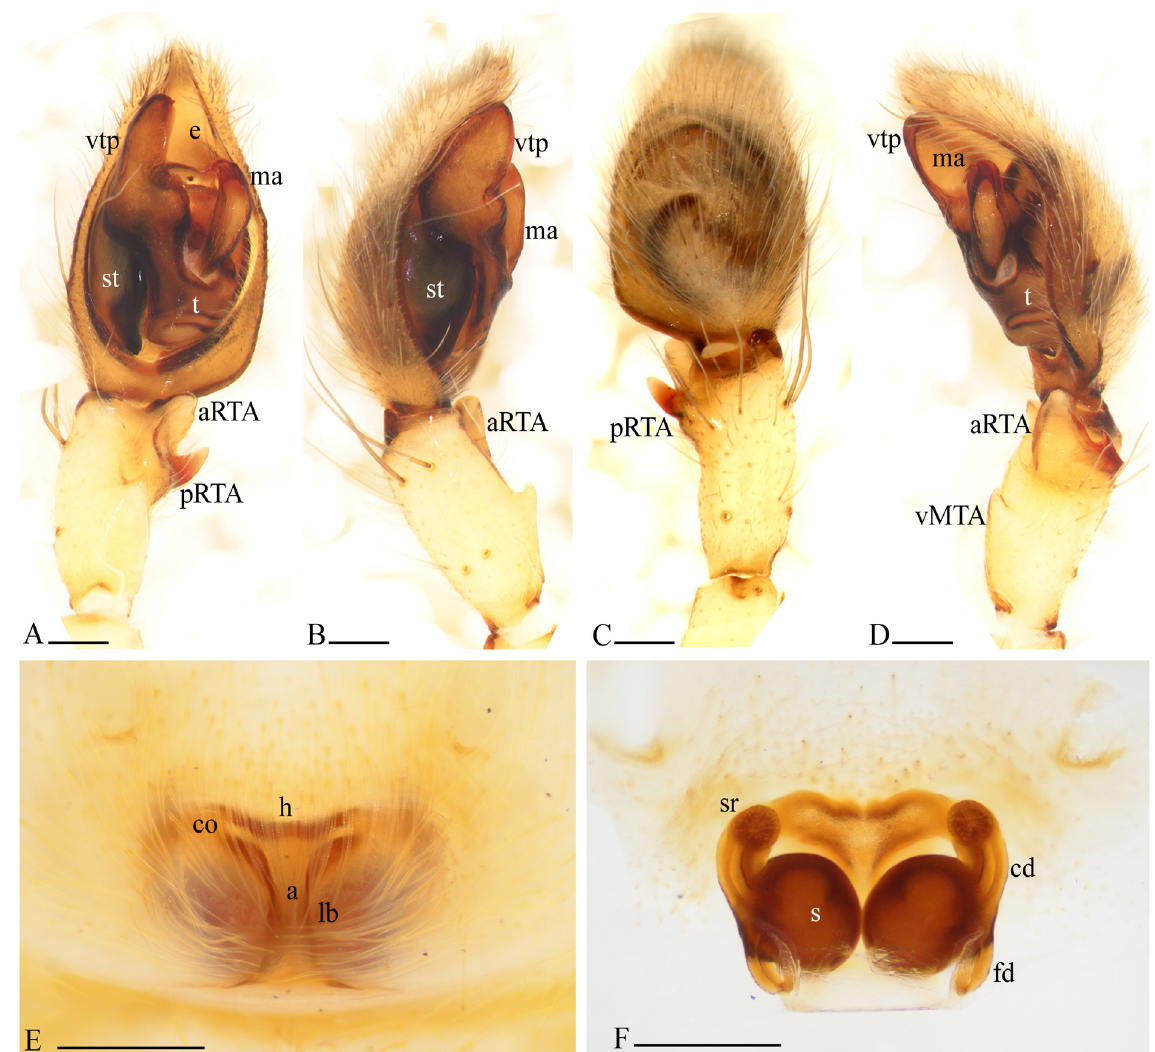
Fig. 32. Anyphaena miniducta sp. nov. A–D . Allotype, ♂ (CNAN-T01515). E–F . Paratypes, ♀♀ (CNAN-T01560, CNAN-T01561). A . Pedipalp, ventral view. B . Pedipalp, prolateral view. C . Pedipalp, dorsal view. D . Pedipalp, retrolateral view. E . Epigynum, ventral view. F . Epigynum, dorsal view. Scale bars: 0.2